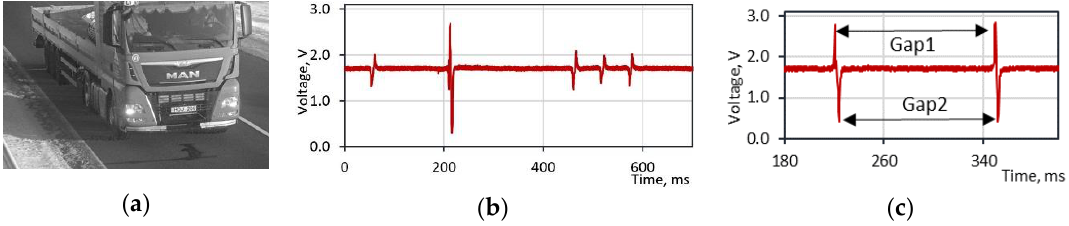
Figure 2. ( a ) Five-axle truck. ( b ) PVDF sensor raw discretized signal of the five-axle truck. ( c ) The time difference between two adjacent peaks is calculated by the average of the upper and lower gaps.